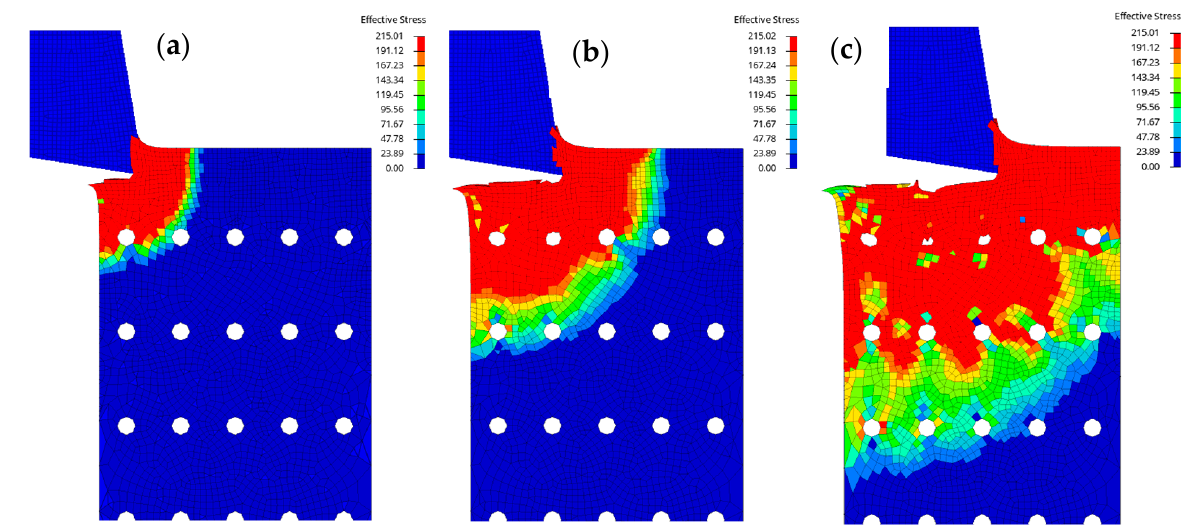
Figure 6. Stress distribution cloud map for the coating at different scraping times, ( a ) t = 0.008 μ s, ( b ) t = 0.01 μ s, and ( c ) t = 0.012 μ s.